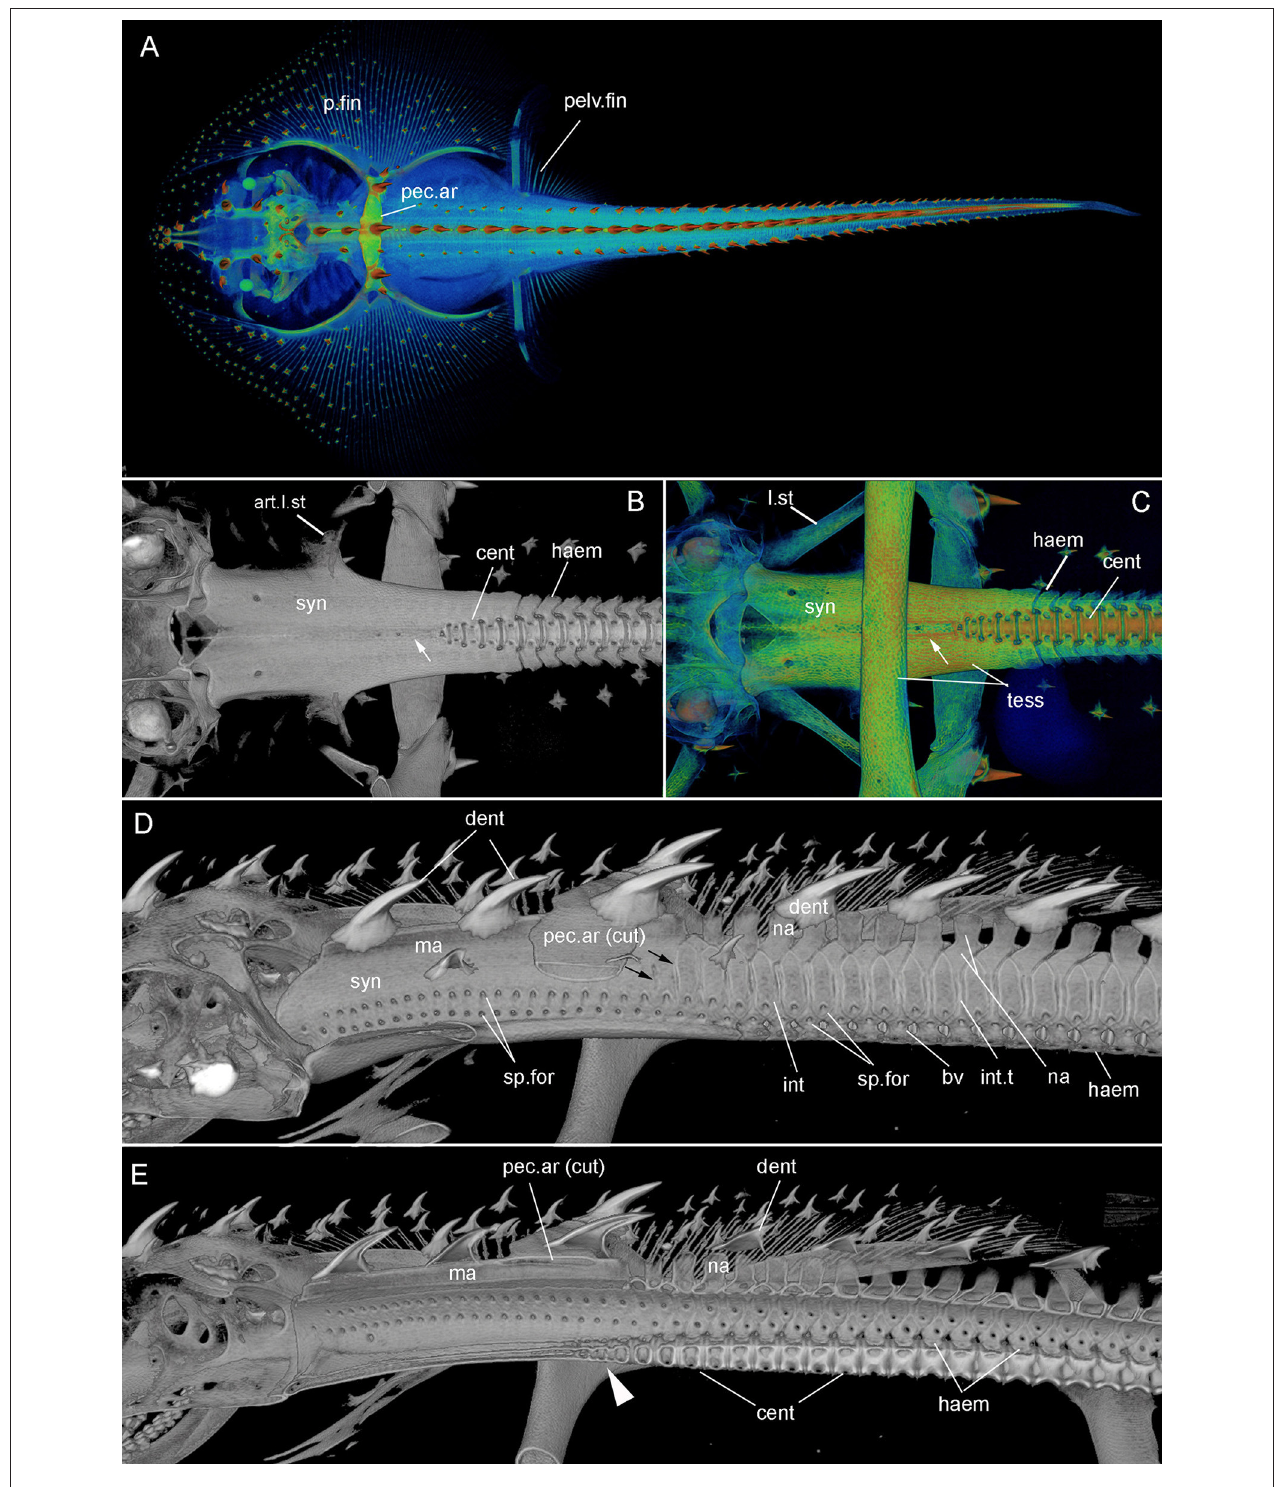
FIGURE 3 | Leucoraja erinacea , hatchling (BMNH 2018.9.26.2), 3D rendered µ CT scans, false colored (A,C), grayscale (B,D,E) . (A) Dorsal view of entire specimen; (B, C) ventral view of posterior braincase, synarcual and anterior unfused vertebrae. White arrows indicate shallow furrow in ventral surface of the synarcual; (D,E) lateral view, of posterior braincase, synarcual and anterior unfused vertebrae; (E) sagittal section. Black arrows (D) indicate separation of vertebral elements within the posterior synarcual. White arrowhead (E) indicates reduced centra within the posterior synarcual. Abbreviations as in Figures 1 , 2 , also: bv, basiventral; int.t, intervertebral tissue. Anterior to the